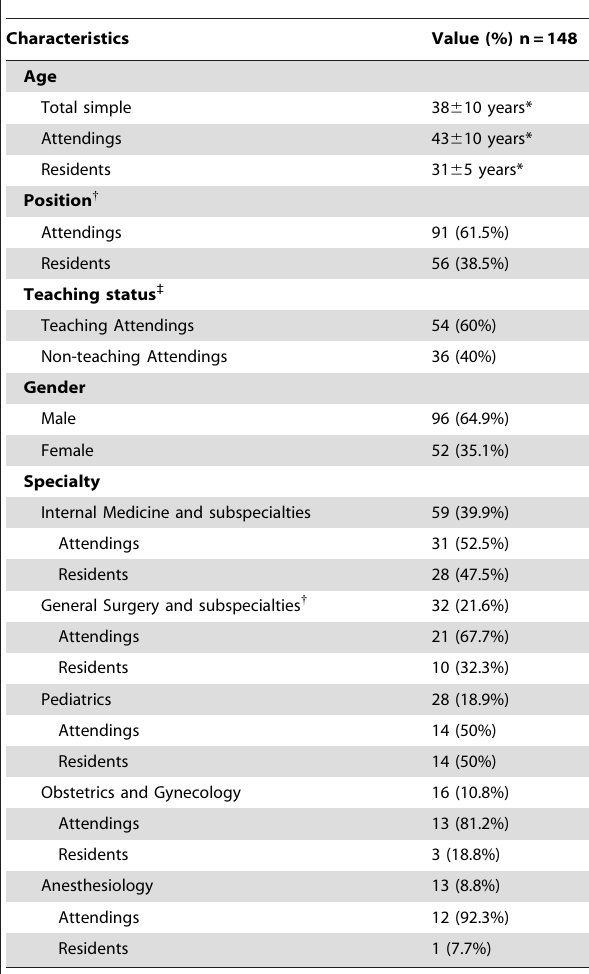
Table 1. Characteristics of study participants.